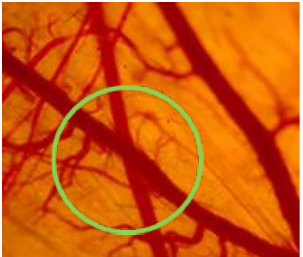
Figure 1. Cross-bridge vessels [8].